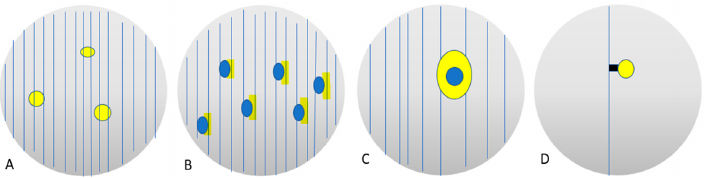
Figure 6. Mechanisms of drug release in the vitreous. ( A ) Slow drug release through polymer’s mechanical entrapment. ( B ) Slow drug release through polymer’s electrostatic interaction. ( C ) Slow drug release through polymer’s mechanical entrapment via micro- or nano-particle. ( D ) Slow drug release through polymer’s chemical binding.